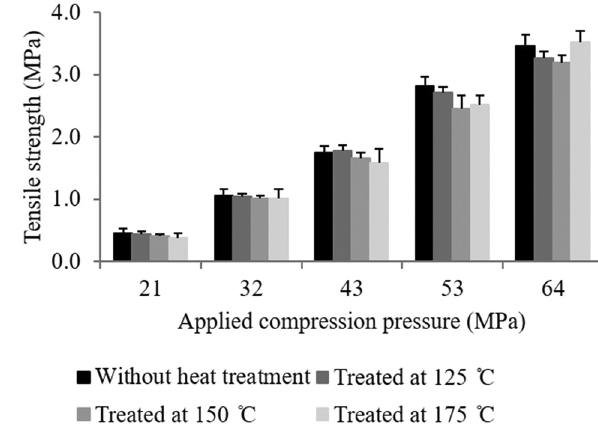
Figure 4: Relations between percentage increase in compact por - osity and thickness of compacts at di ff erent heat treatment temperatures.